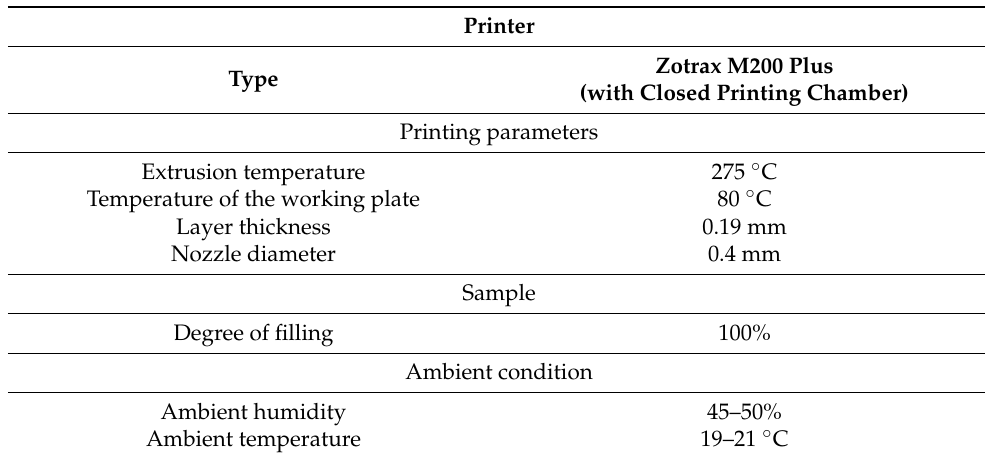
Table 3. Conditions for printed samples.